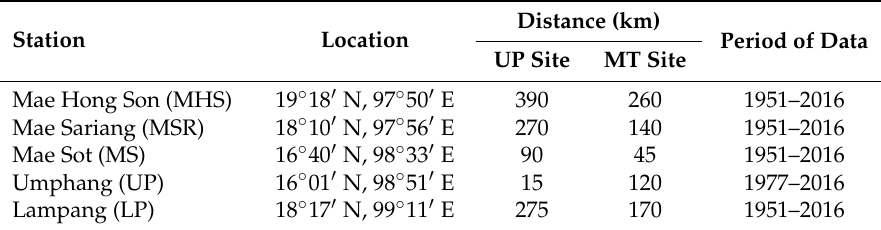
Table 2. Detail of five local meteorological